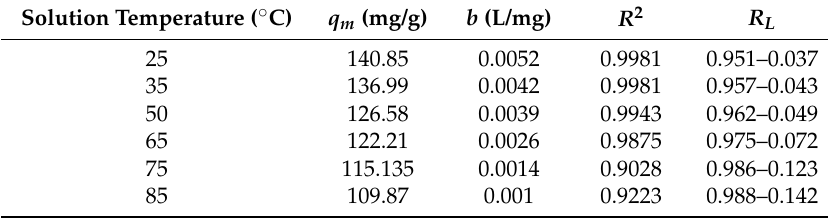
Table 1. Estimated parameters of the Langmuir isotherm for copper sorption onto MANSG at different solution